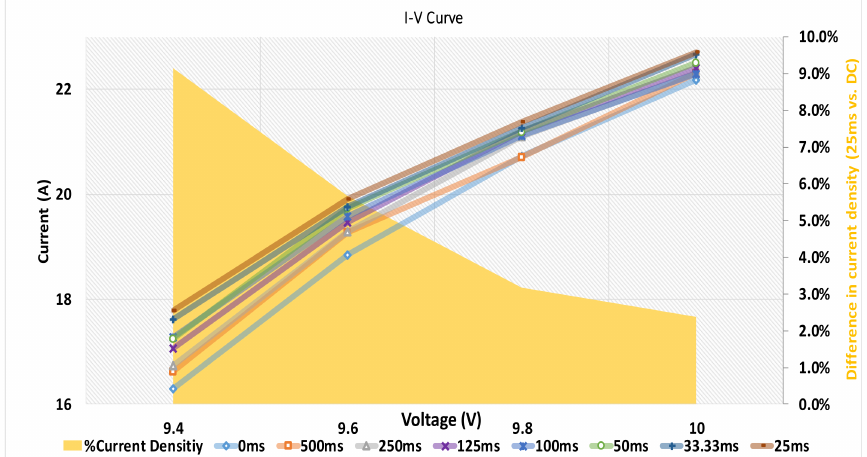
Figure 2. I–V characteristic curve of electrolyzer according to pulse-on time variable.